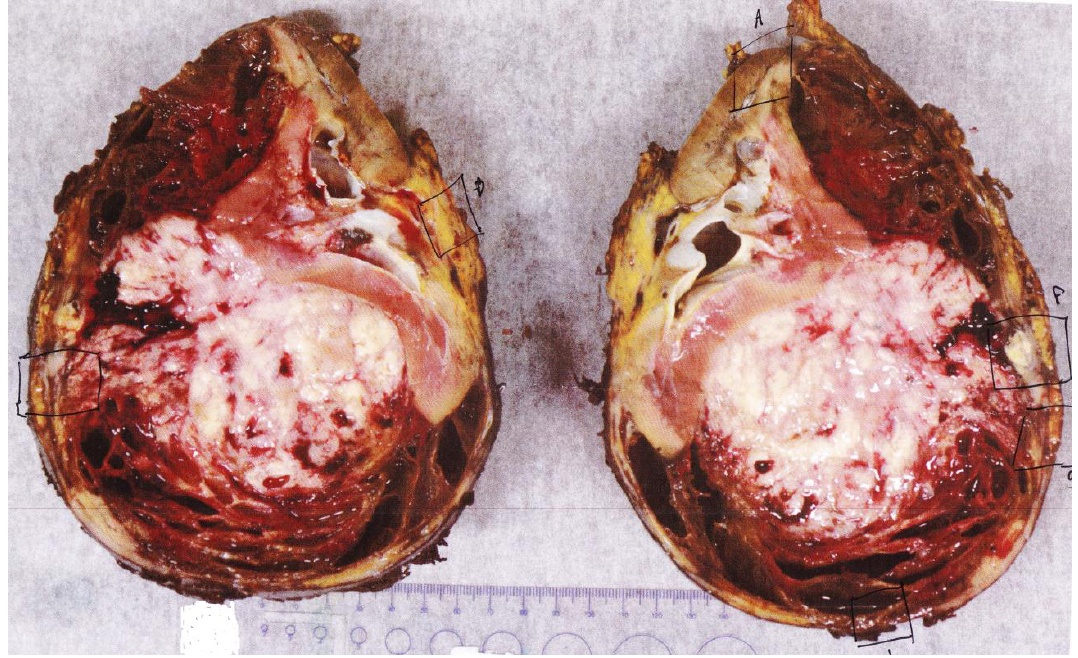
Figure 3. Right kidney specimen – cream and pink colour tumour with mixture of solid and cystic components with haematoma in the lumen of the cyst and possible